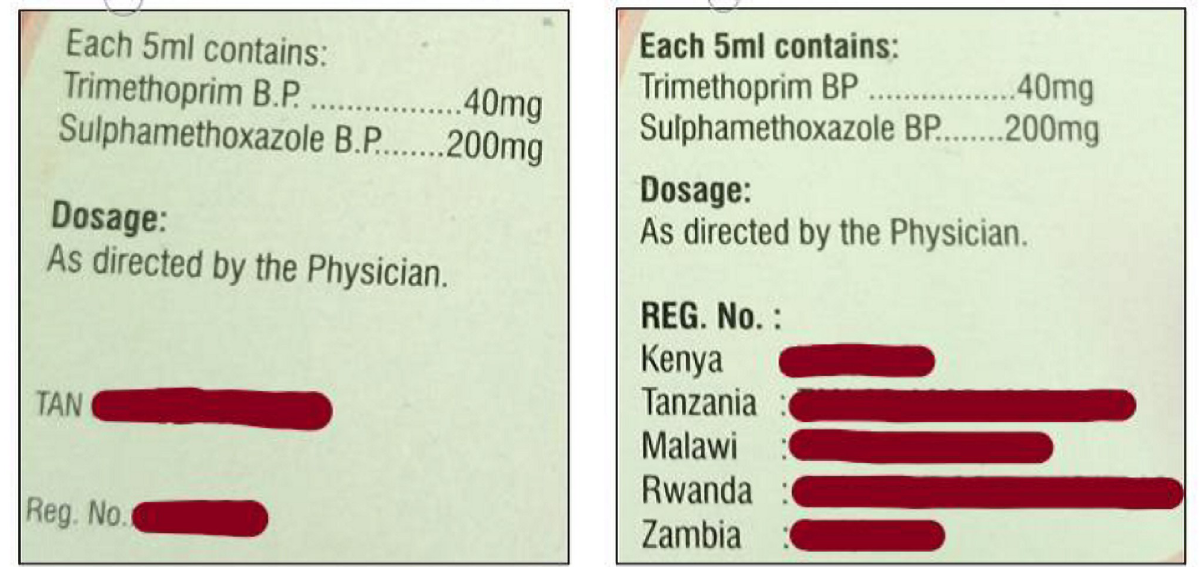
Fig 4. Samples with same batch number but different information on the product